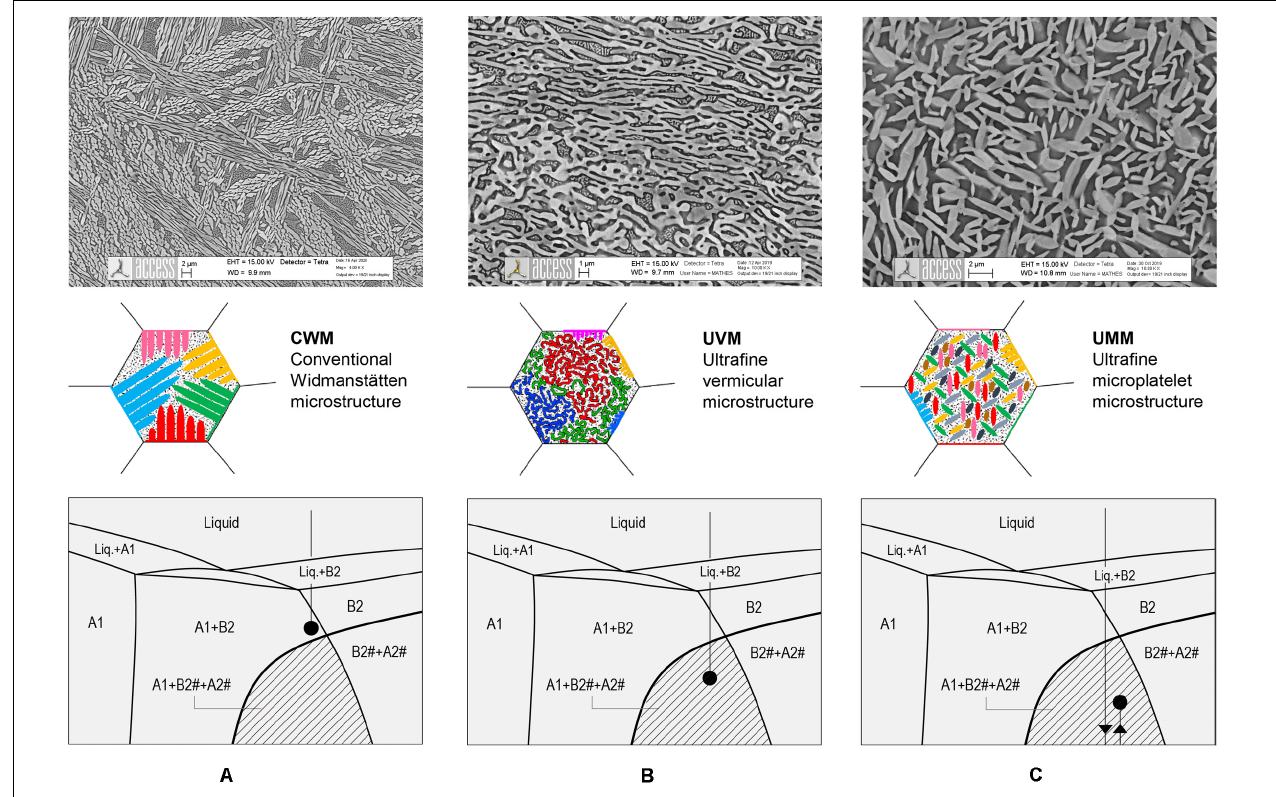
FIGURE 1 | Overview of dual phase microstructures forming in Al-(Co)-Cr-Fe-Ni alloys from the parent BCC-B2 phase under different cooling regimes. The cooling rate increases from left to right. According to the morphology of the FCC phase we distinguish (A) classical Widmanstätten laths and colonies, (B) ultrafine vermicular network and (C) ultrafine micro-platelets. The colors in the icons represent different crystal orientations of the FCC phase inside one parent BCC-B2 grain. The corresponding transformation pathways are schematically depicted on simplified phase diagram sections. The micrographs in the top row are taken from AlCrFe 2 Ni 2 samples produced by arc melting of 300 g buttons (A) , 50 g buttons (B) and laser powder bed fusion, L-PBF, with a post-build heat treatment at 950 ◦ C/6 h (C)